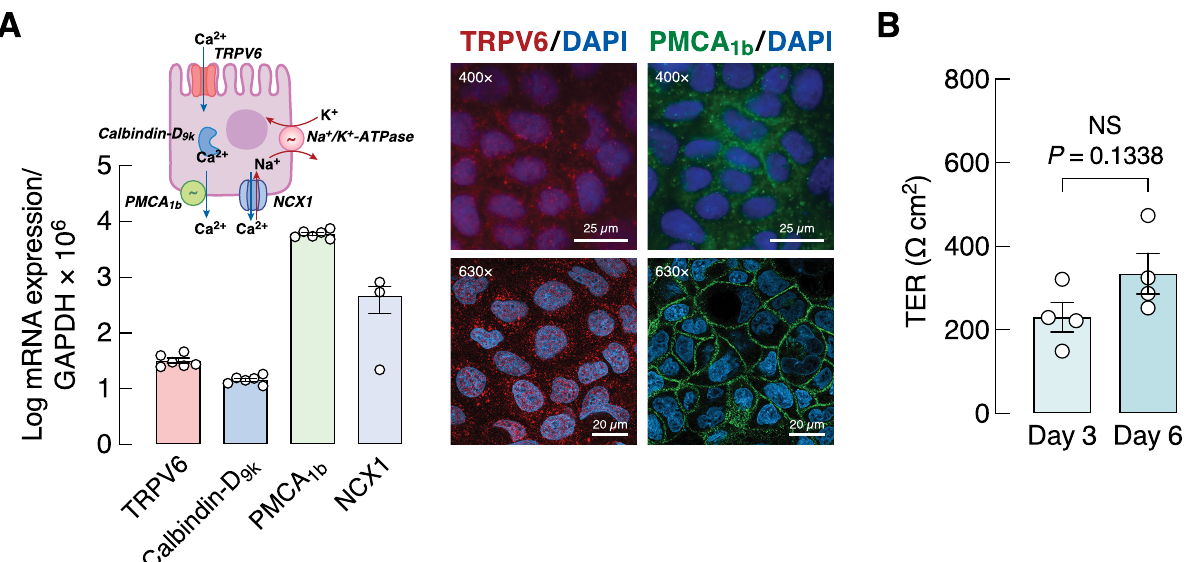
Fig 1. Expression of genes and proteins related to transepithelial calcium transport, and transepithelial resistance in Caco-2 cells. (A) Expression of TRPV6, calbindin-D 9k , PMCA 1b and NCX1 mRNA, as determined by quantitative real-time PCR. Representative fluorescent photomicrographs from conventional fluorescent microscope (400 × ; Nikon model Eclipse Ni-U) and confocal laser scanning microscope (630 × ; Carl Zeiss model Zeiss LSM800) confirmed the presence of TRPV6 (red) and PMCA 1b (green) protein expression in 3-day Caco-2 monolayer [blue, nuclei stained with 4 0 ,6-diamidino-2-phenylindole (DAPI)]. The drawing diagram shows localization of calcium transporters in a Caco-2 cell. TRPV6, transient receptor potential vanilloid subfamily member 6; PMCA 1b , plasma membrane Ca 2+ -ATPase 1b; NCX1, Na + /Ca 2+ exchanger 1; NKA, Na + / K + -ATPase. (B) Transepithelial resistance (TER) of Caco-2 cells after being cultured on Snapwells for 3 or 6 days (n = 4/group; two-tailed, unpaired Student’s t -test). NS, not